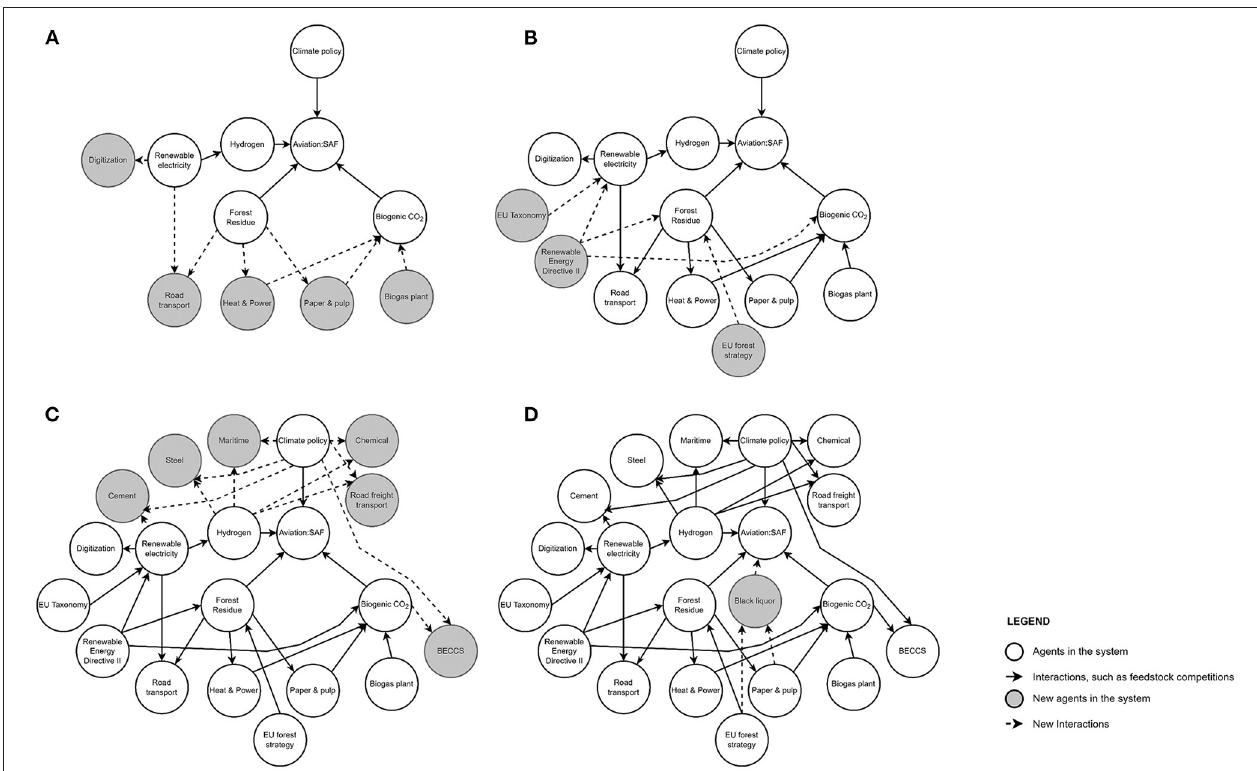
FIGURE 5 | Application of STS approach to assess forest residue, biogenic CO 2 and renewable electricity as SAF feedstock types and their availability in Sweden. (A) Interactions between feedstock and existing markets/sectors; (B) Interactions between feedstock and policies; (C) Interactions between feedstock and other emerging markets/sectors; (D) Inclusion of new feedstock